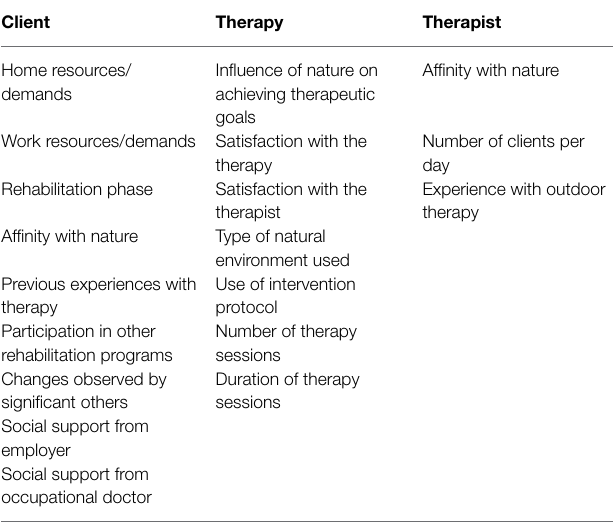
TABLE 2 | Context indicators of the client, therapy, and therapist.